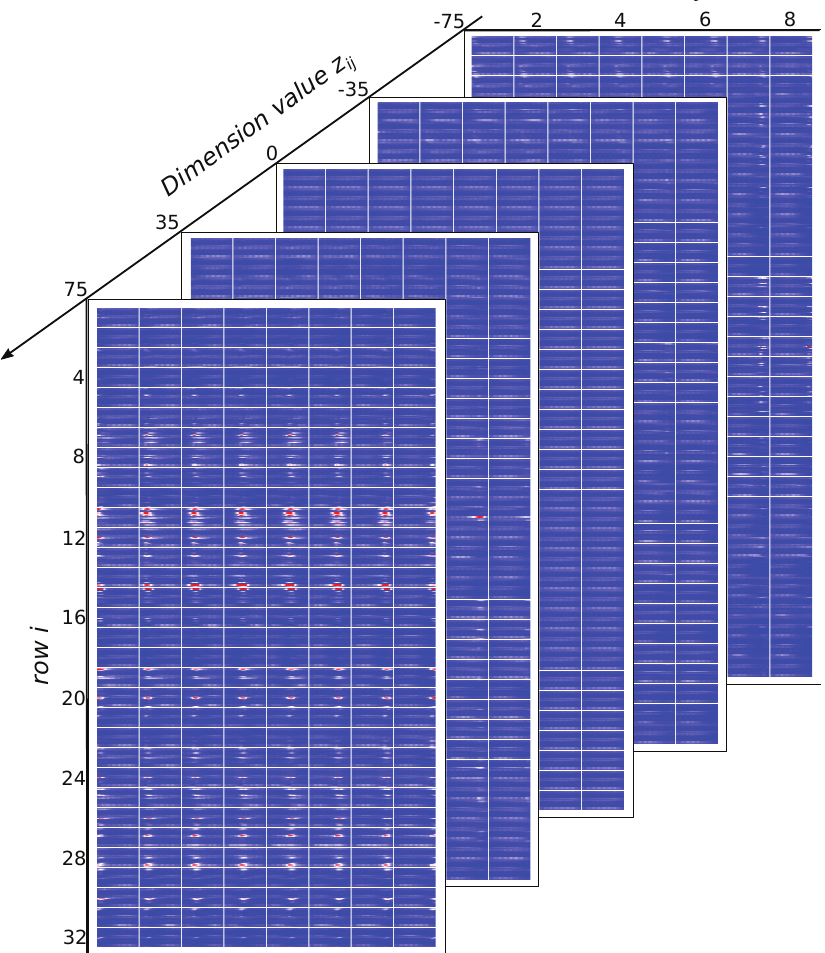
Figure 10. The sEMG linear envelope corresponding to each dimension of the factorized